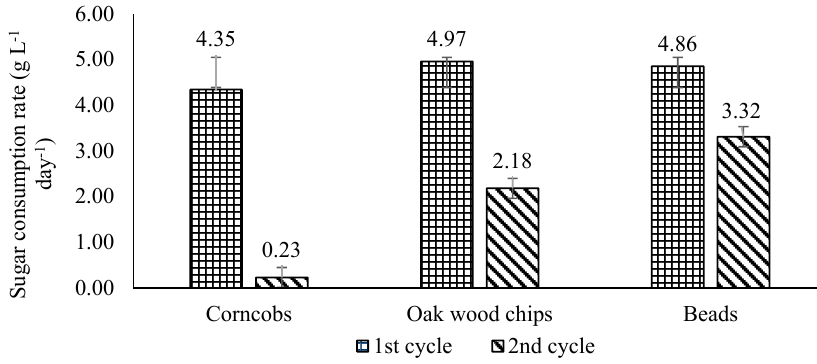
Figure 1. Sugar consumption rates for two cycles of balsamic-styled vinegar (BSV) fermentation using recycled immobilized cells.